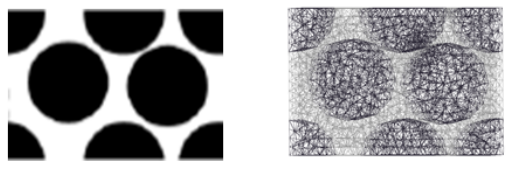
Figure 1. (A) Cross section of braided composite,